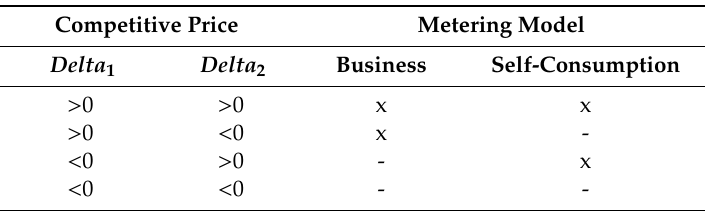
Table 6. Competitive prices and corresponding metering models in the rooftop PV market (“x”, beneficial; “-”, not beneficial).